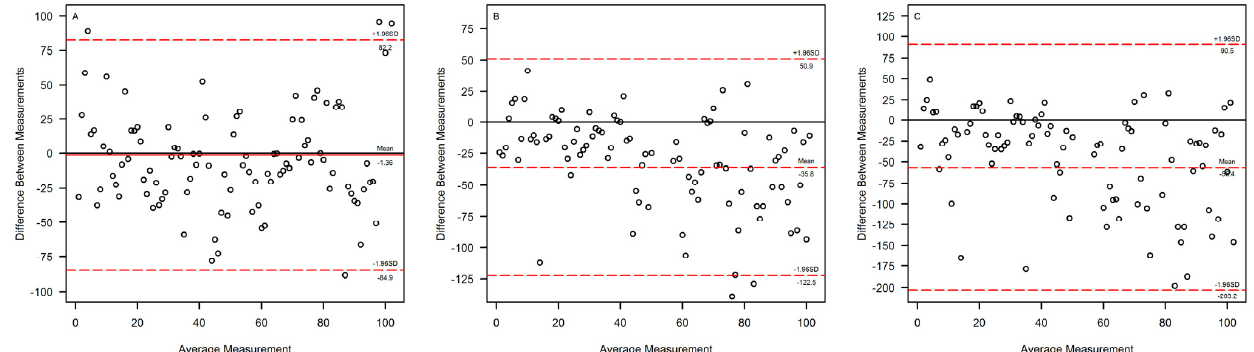
Figure 2. Linear regressions between ( A ) estimated glomerular filtration rate (eGFR) calculated by means of the CKDEPI formula (eGFR CKDEPI ) vs. measured creatinine clearance (mCL CR ), ( B ) eGFR estimated by means of the Cockcroft–Gault formula (eGFR CG ) vs. mCL CR and ( C ) eGFR estimated by means of the MDRD formula (eGFR MDRD ) vs. mCL CR . The dashed lines represent the line of regression. The dotted lines are the identity lines.